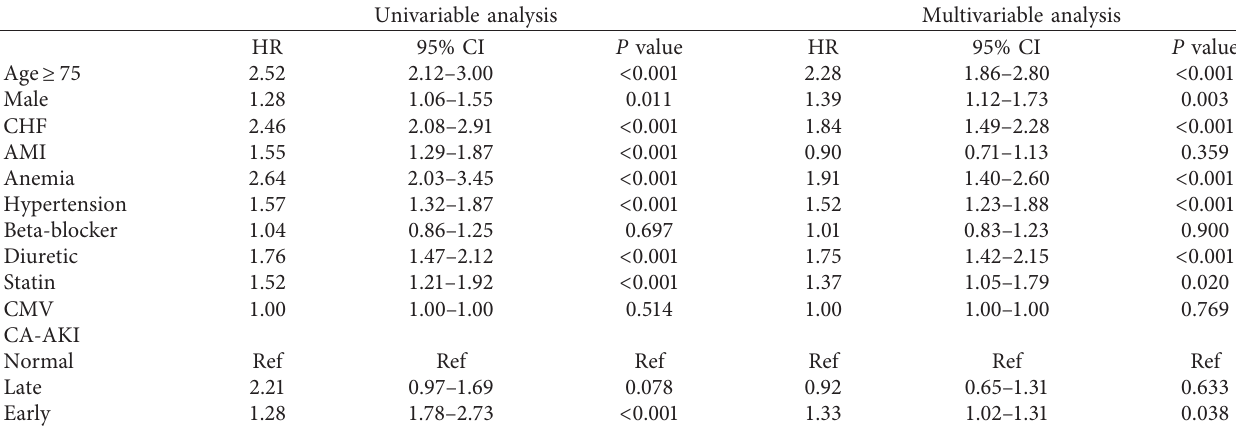
Table 2: Univariable and multivariable analysis of risk factors for long-term